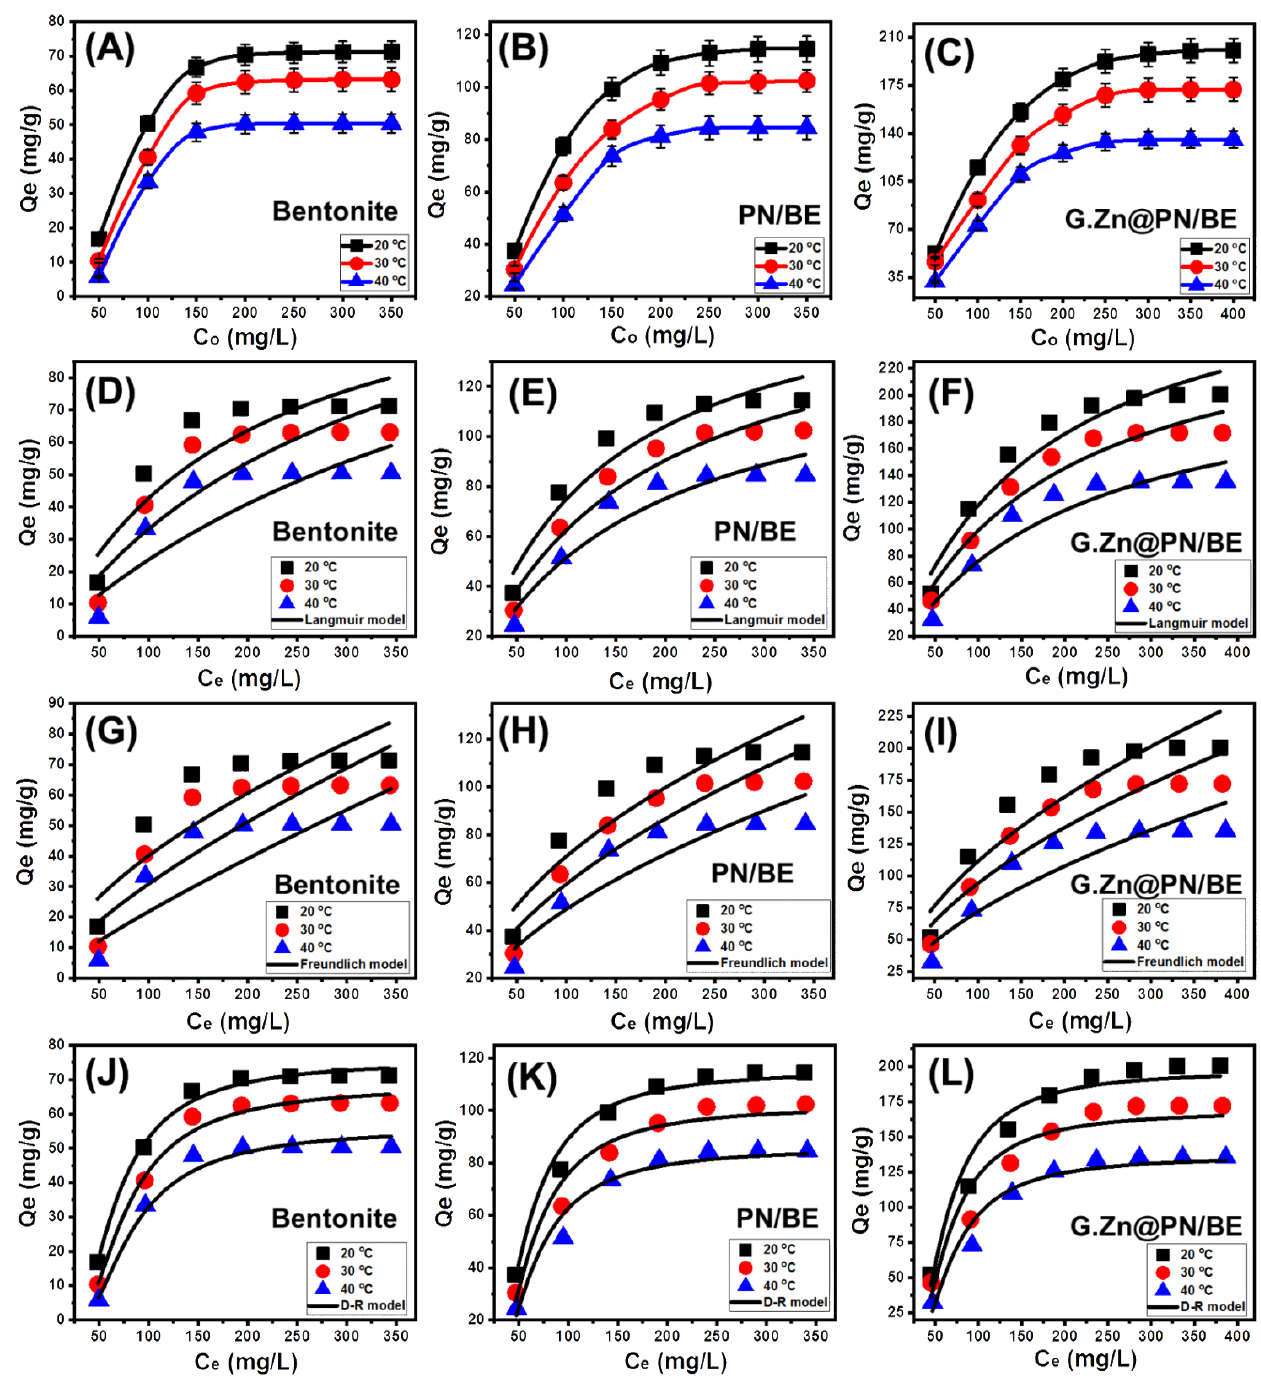
Figure 6. The retention behavior of As (V) ions by BE, PN/BE, and G.Zn@PN/BE as function of the initial concentration ( A – C ), fitting of the As (V) adsorption results with the Langmuir model ( D – F ), fitting of the As (V) retention results with the Freundlich model ( G – I ), and fitting of the As (V) adsorption results with the D-R model ( J – L ).